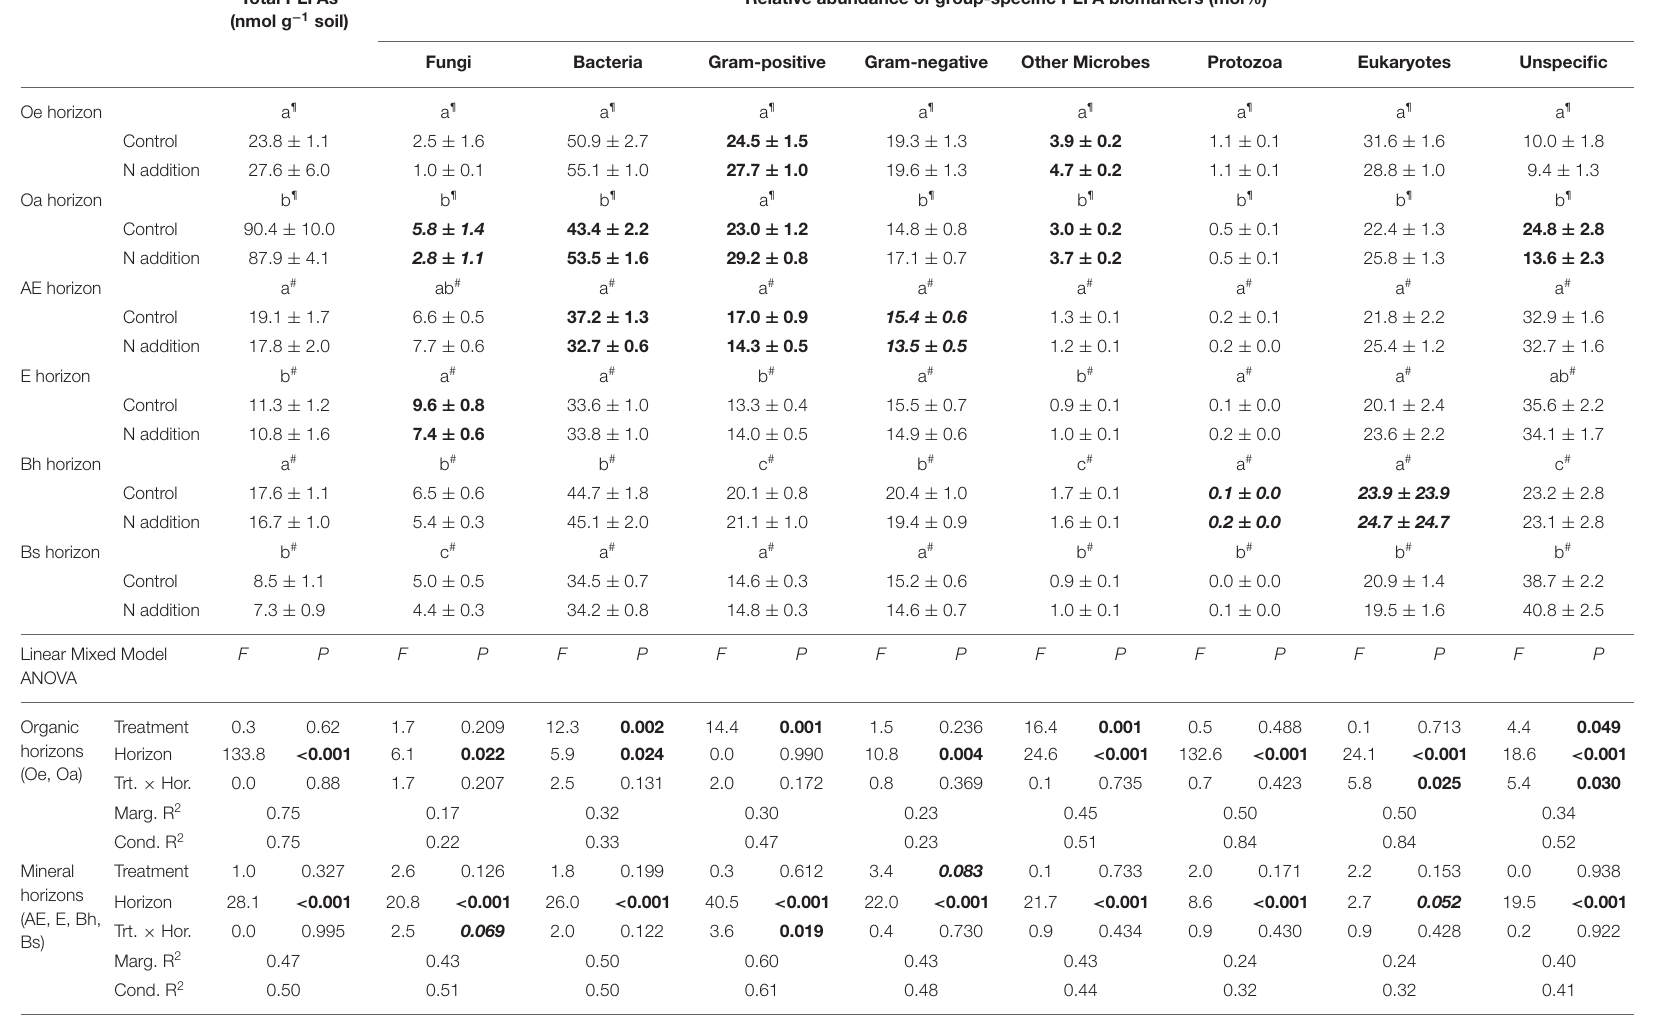
TABLE 4 | Total PLFA concentrations (nmol g − 1 soil) and relative abundance of group-specific PLFA biomarkers (mol%) in response to long-term N addition at Klosterhede